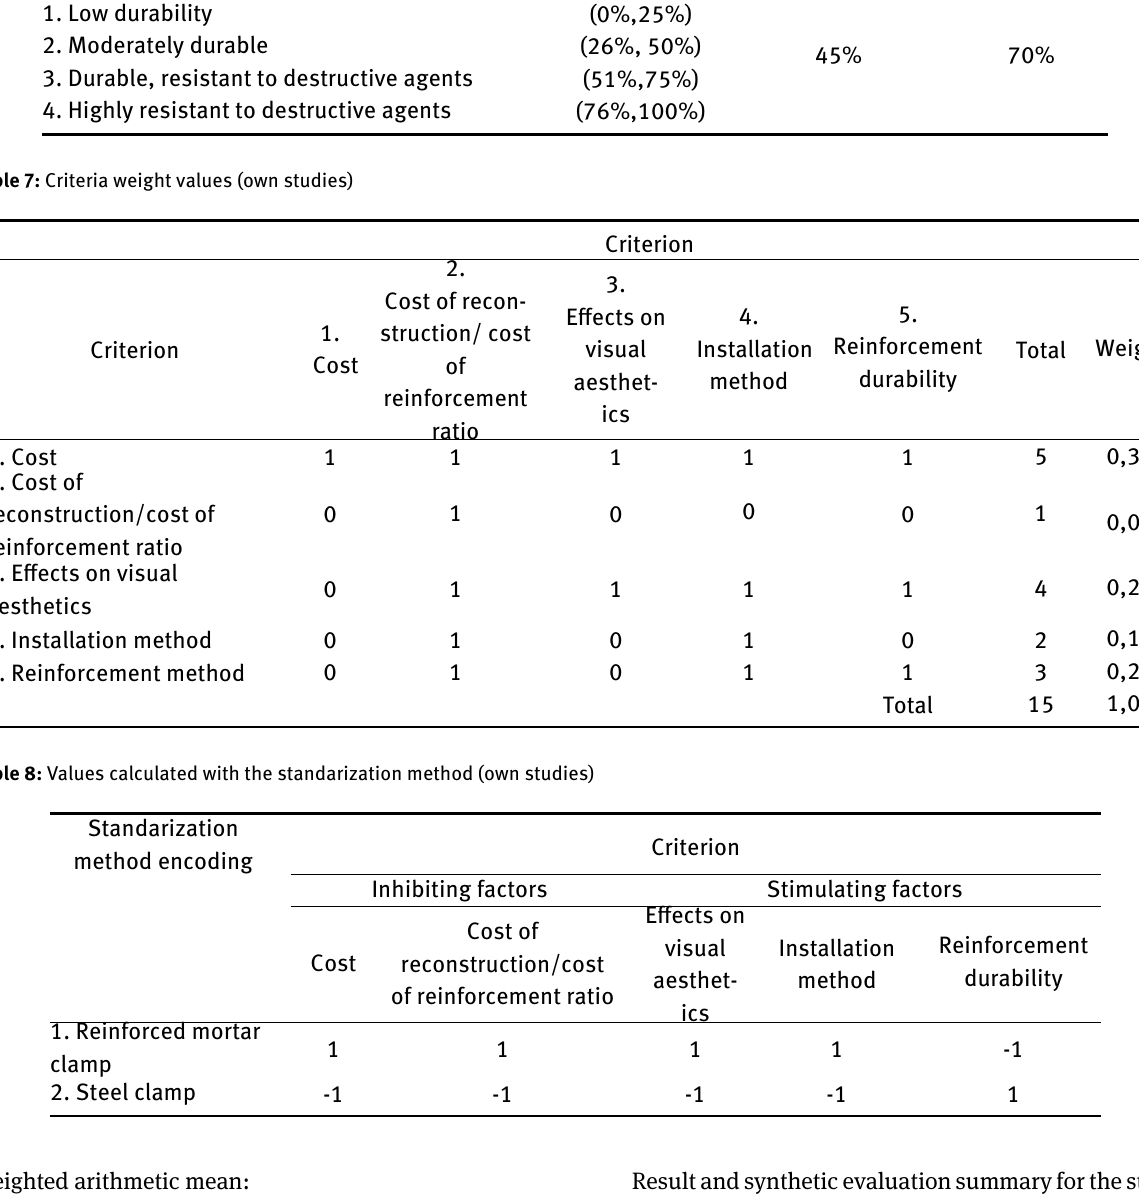
Reinforcement durability